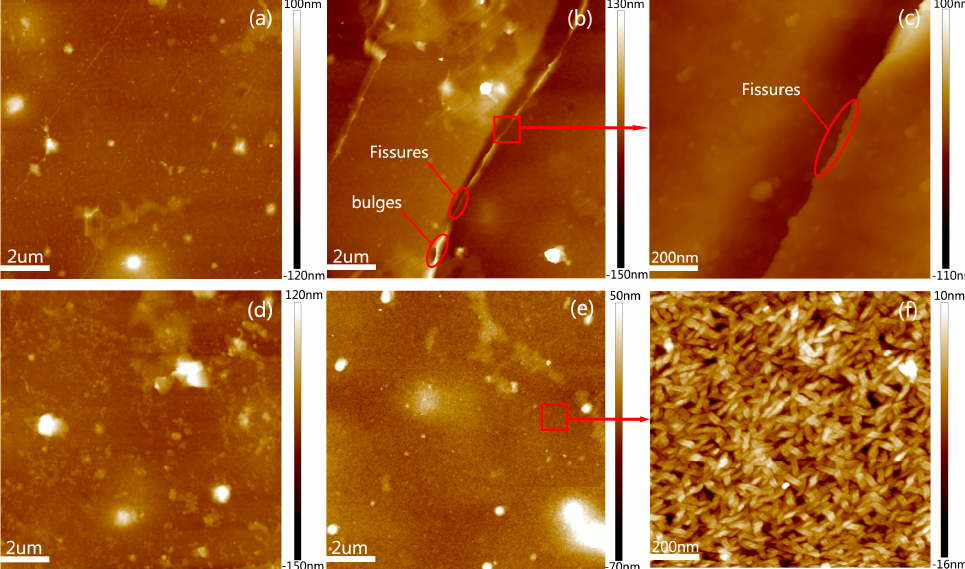
Figure 7. The AFM images of the devices after bending and cyclic bending 1000 times at a radius of 10 mm. The surface of ZrO 2 dielectric layers ( a ) without and ( b ) with cyclic bending; ( c ) magnified image. The surface of AZO electrodes ( d ) without and ( e ) with cyclic bending; ( f ) magnified image.